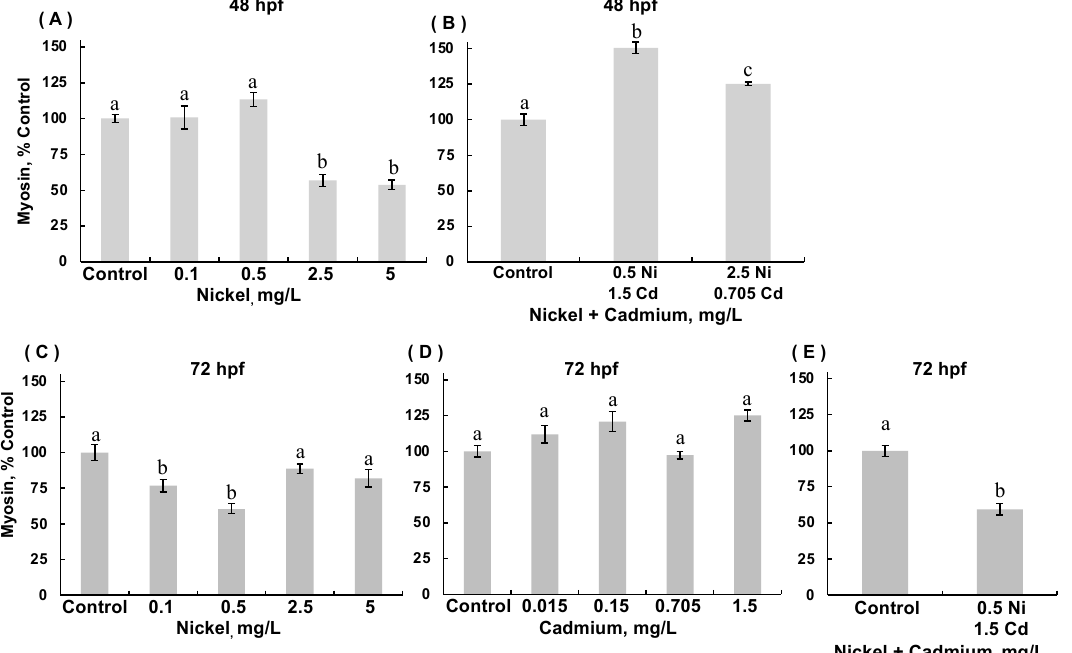
Figure 7. Modified myosin protein expression in 48 hpf ( A , B ) and 72 hpf ( C – E ) zebrafish embryos reared in medium containing 0.1–5 mg/L Ni, 0.15–1.5 mg/L Cd, and combinations of either 0.5 mg/L Ni + 0.15 mg/L Cd or 2.5 mg/L Ni + 0.705 mg/L Cd. Fixed embryos were immunostained for myosin heavy chain protein; staining intensity in metal-exposed embryos was expressed as a percent of staining in control embryos. ( A ): 48 hpf with Ni exposure, ANOVA p < 0.0001. ( B ): 48 hpf with combined exposure to Ni + Cd, ANOVA p = 0.0003. ( C ): 72 hpf with Ni exposure, ANOVA p = 0.0052. ( D ) 72 hpf with Cd exposure, ANOVA p = 0.0067. ( E ): Too few embryos survived exposure to 2.5 mg/L Ni + 0.705 mg/L Cd through 72 hpf to permit valid comparison with controls. (Data are means ± SEM for N = 50–80 surviving embryos.).